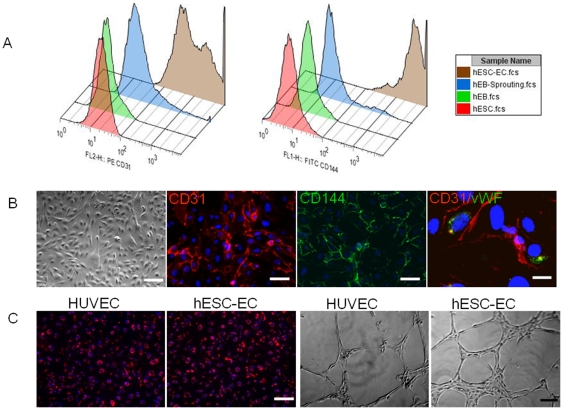
In vitro characterization of hESC-ECs.(A) During hESC differentiation and endothelial isolation, FACS analysis shows CD31 and CD144 increase significantly. (B) Morphogenesis shows the cells possess cobblestone-like morphology. Histology shows CD31 and CD144 are expressed on cell membranes, and vWF in the cytoplasm. Scale bars = 20 µm (left), 10 µm (middle two), 5 µm (right). (C) Similar to HUVECs, hESC-ECs also can uptake ac-DiI-LDL and form tube-like structures on Matrigel. Scale bars = 20 µm.